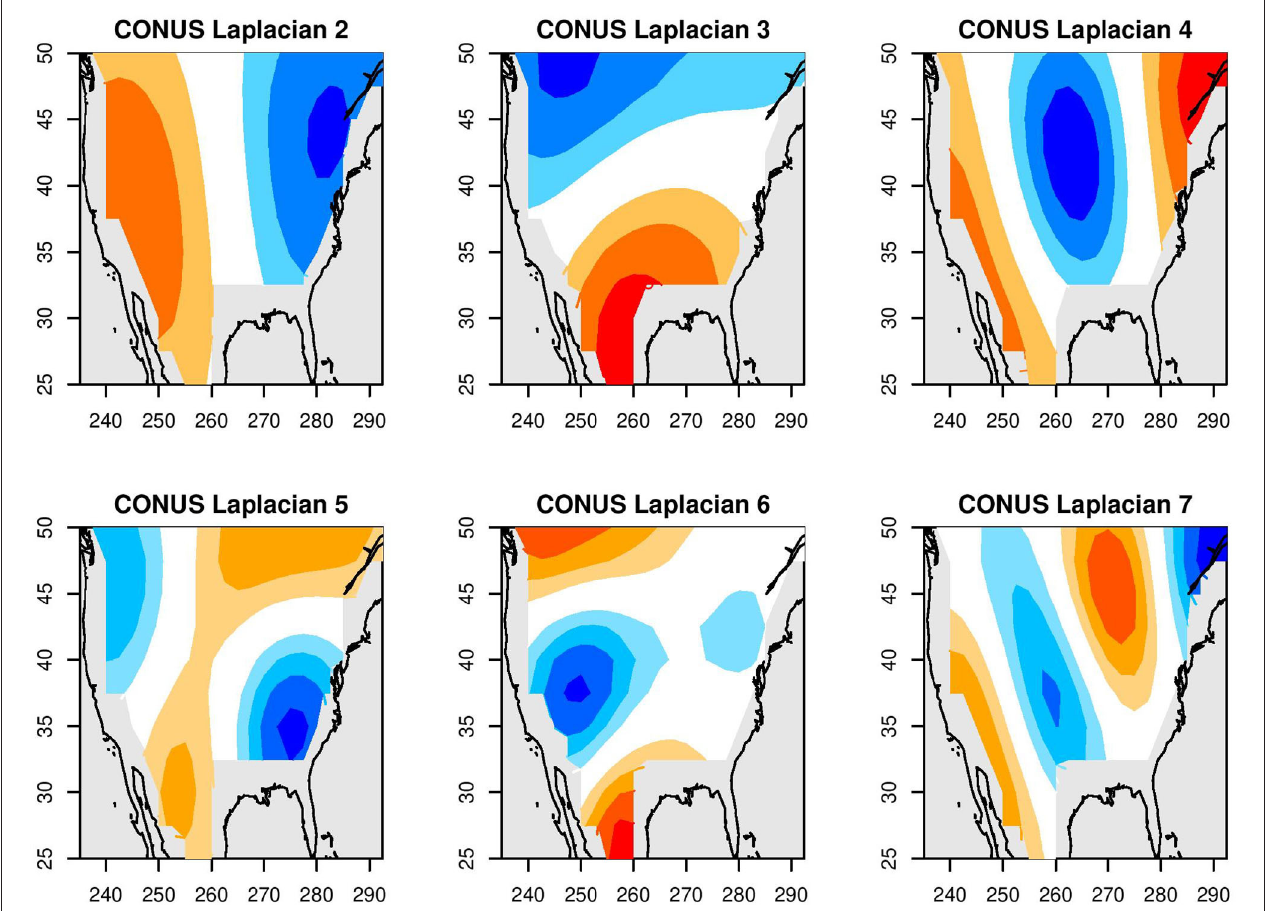
FIGURE 1 | Laplacian eigenvectors 2–7 over CONUS. The first Laplacian eigenvector is not shown as that is simply the spatial average over the